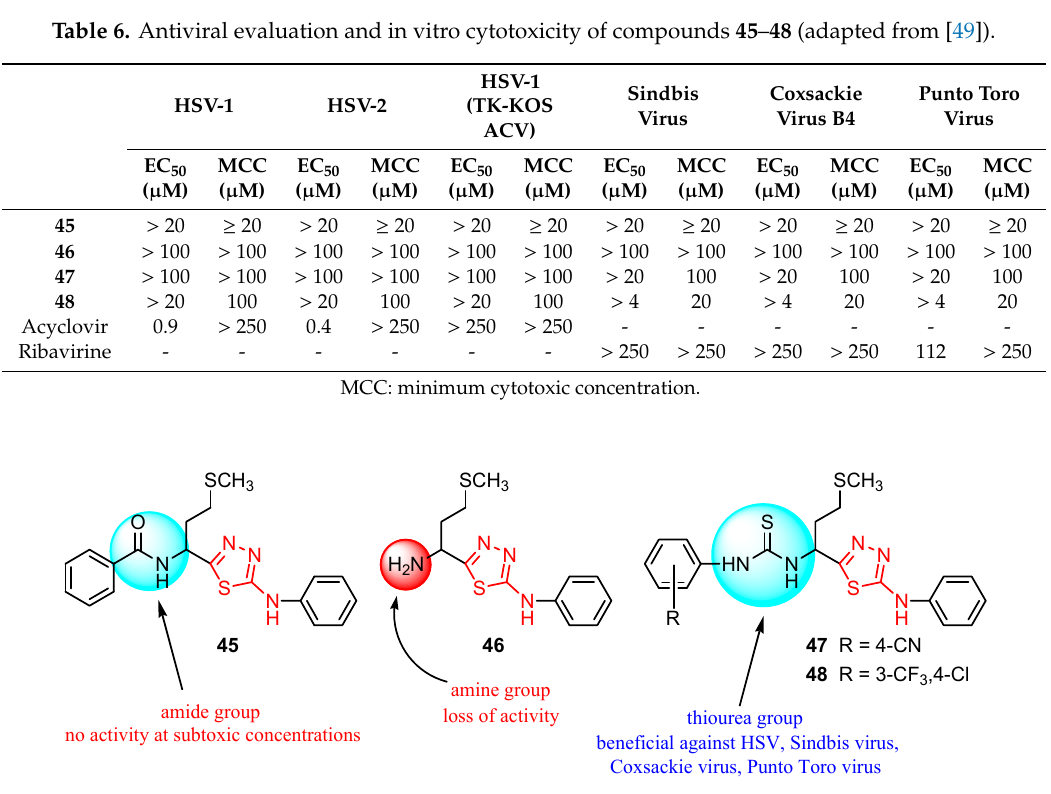
Table 6. Antiviral evaluation and in vitro cytotoxicity of compounds 45 – 48 (adapted from [49]).